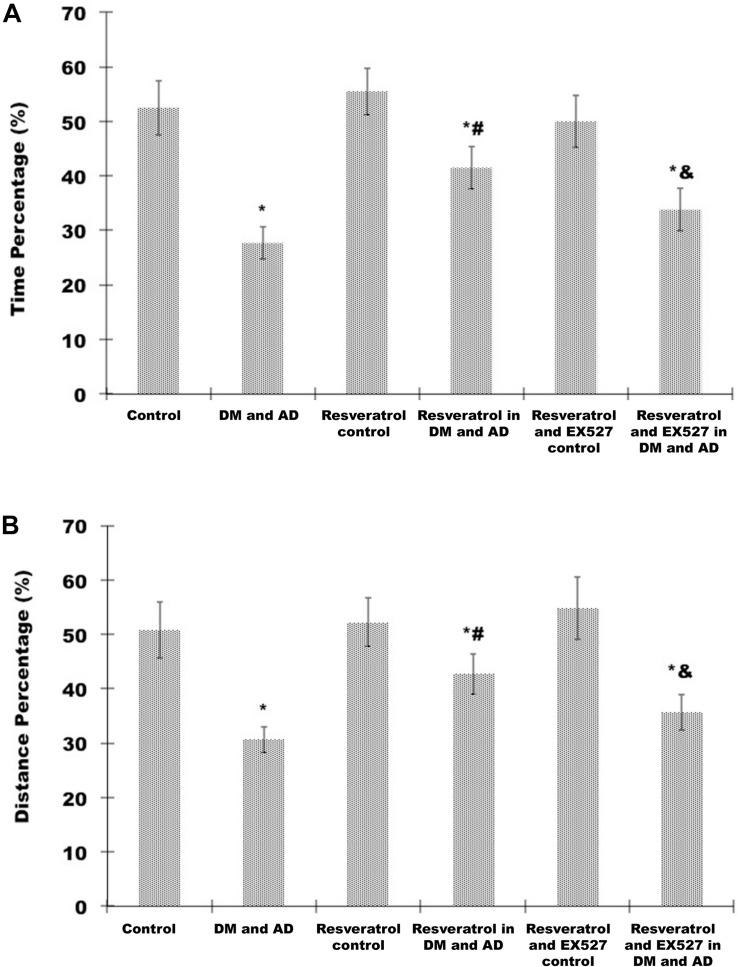
Effects of resveratrol on memory impairment in DM and AD rats. A probe test was used to analyze maintenance of memory in the MWM by measuring the percentage of time spent (A) and distance swum (B) in the target quadrant. Three independent experiments were performed. Data are expressed as mean ±SD. ∗P < 0.05 vs. control group, #P < 0.05 vs. DM and AD group, &P < 0.05 vs. resveratrol in DM and AD group.